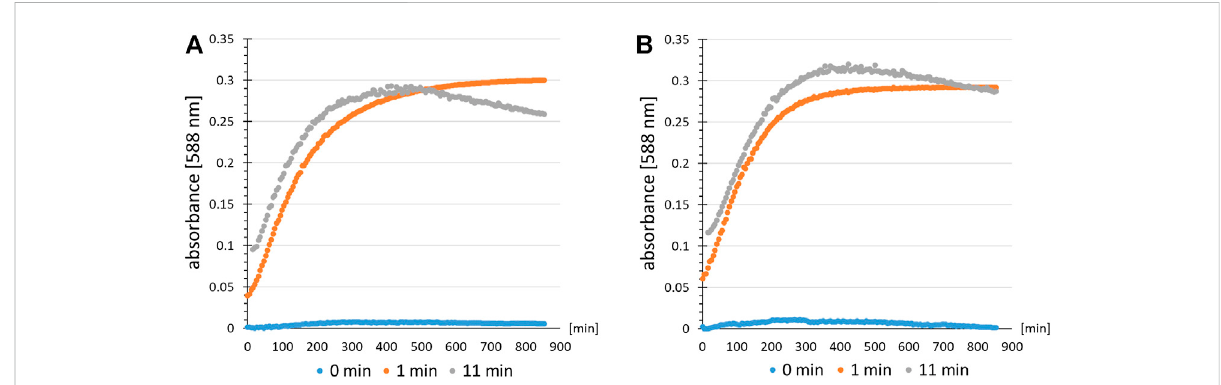
FIGURE 9 Time resolved chromophore maturation of amilCP(Y63ONBY) detected by an absorption assay after light-induced ncAA decaging. Colored dots indicate the time for which the protein solution of amilCP(Y63ONBY) was irradiated with UV-light prior to data recording (absorbance at λ = 588 nm). Controls (0 min, blue) are without irradiation. Comparison of proteins produced using E. coli strain (A) B-95. Δ A NK53 or (B) B-95. Δ A.